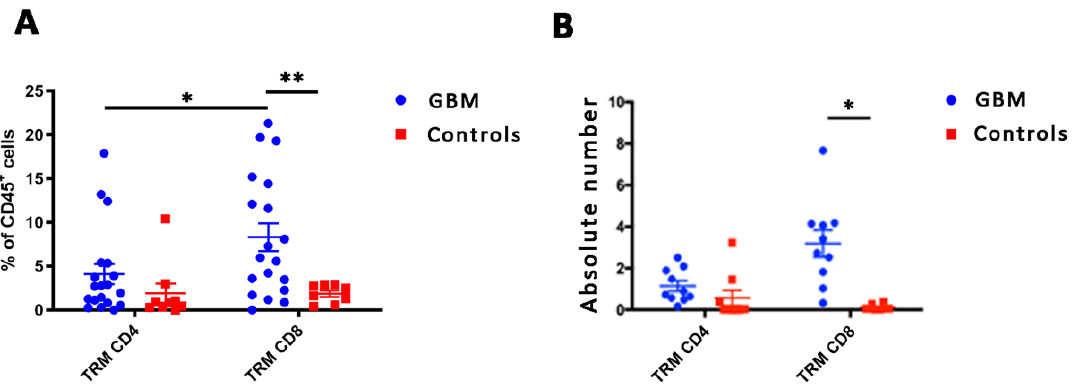
Figure 2. Cumulative analysis of the frequency ( A ) and absolute values ( B ) of TRM cells in 20 GBM and 9 meningioma samples. Values are expressed as mean percentage ± SE. Statistical analysis was performed by Multiple t-test Analysis, * p < 0.05, ** p < 0.01.